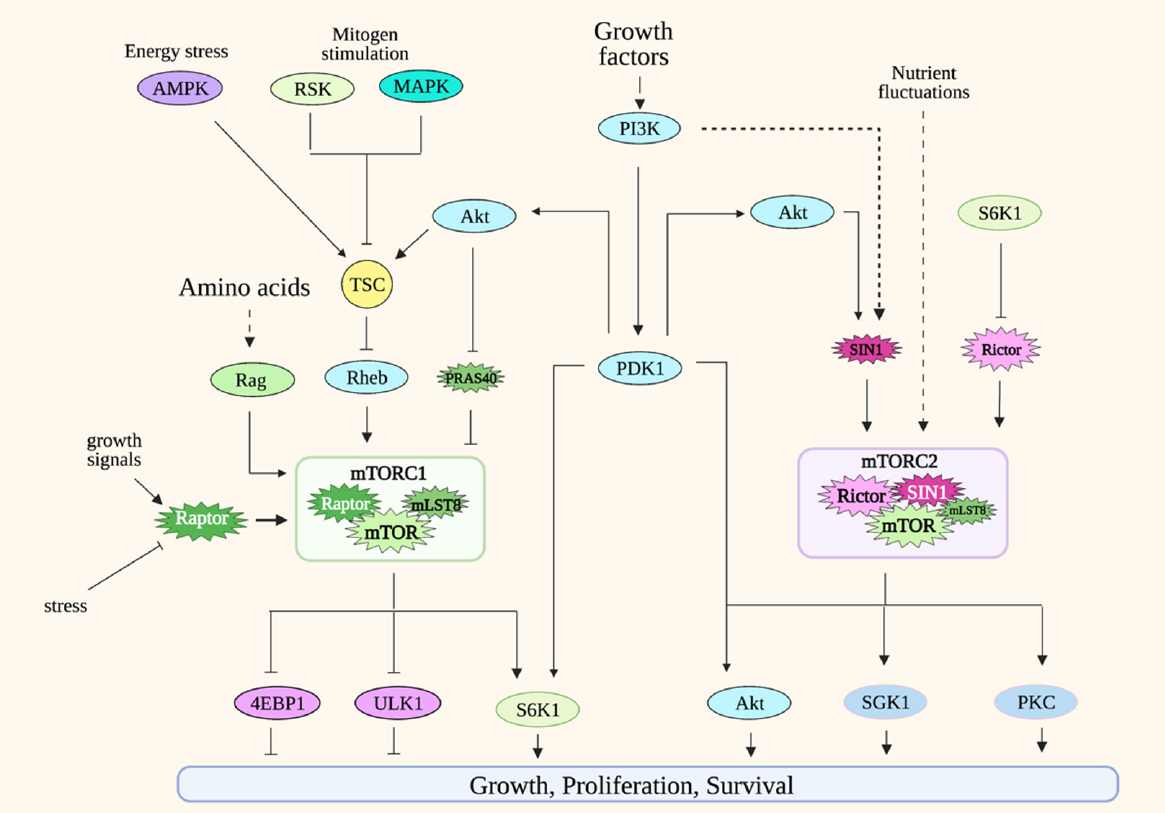
Figure 1. Simplified scheme of mTORC1 and mTORC2 signaling. mTORC1 is active in the presence of nutrients such as amino acids. Its activation is potentiated by growth factors/PI3K signaling. Modulation of mTORC1 occurs at many levels, including via post-translational regulation of its components such as raptor and via the GTPases Rag heterodimers and Rheb. Other environmental signals are conveyed to mTORC1 via the tuberous sclerosis complex (TSC), which acts as a break for mTORC1 signaling during unfavorable growth conditions. mTORC2 is activated by growth factors/PI3K signaling and during nutrient fluctuations. Less is known on mTORC2 regulation, but so far, its components rictor and SIN1 undergo posttranslational modifications that modulate mTORC2 activity. mTORC1 phosphorylates numerous substrates to either promote anabolic metabolism or inhibit catabolic processes. mTORC2 phosphorylates substrates that are involved in proliferation or promoting cell survival during stress conditions. Solid lines indicate direct regulation; dashed lines indicate more indirect regulation. Refer to Abbreviations.